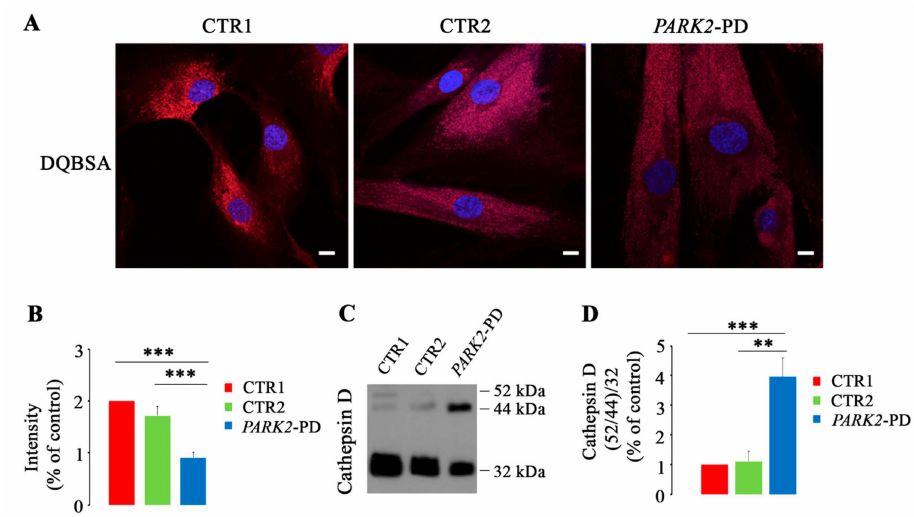
Figure 2. Alterations of lysosomal activity in PARK2 -PD cells. ( A , B ) Cells were incubated in the presence of Red DQ-BSA and immunofluorescence intensity was quantified by ImageJ software. Nuclei were labeled with DAPI (blue). Scale bar: 10 µ m. ( C , D ) Relative abundance of three Cathepsin D forms was assessed by western blotting and quantified by densitometry normalizing against 32 kDa mature form. (Data represent the mean ± SE of at least three independent experiments (* p ≤ 0.05, ** p ≤ 0.01 *** p ≤